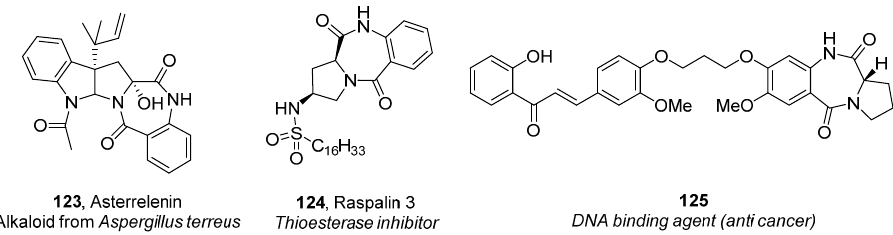
Figure 8. Relevant examples of bioactive pyrrolo[1,4]benzodiazepine-2,5-diones.